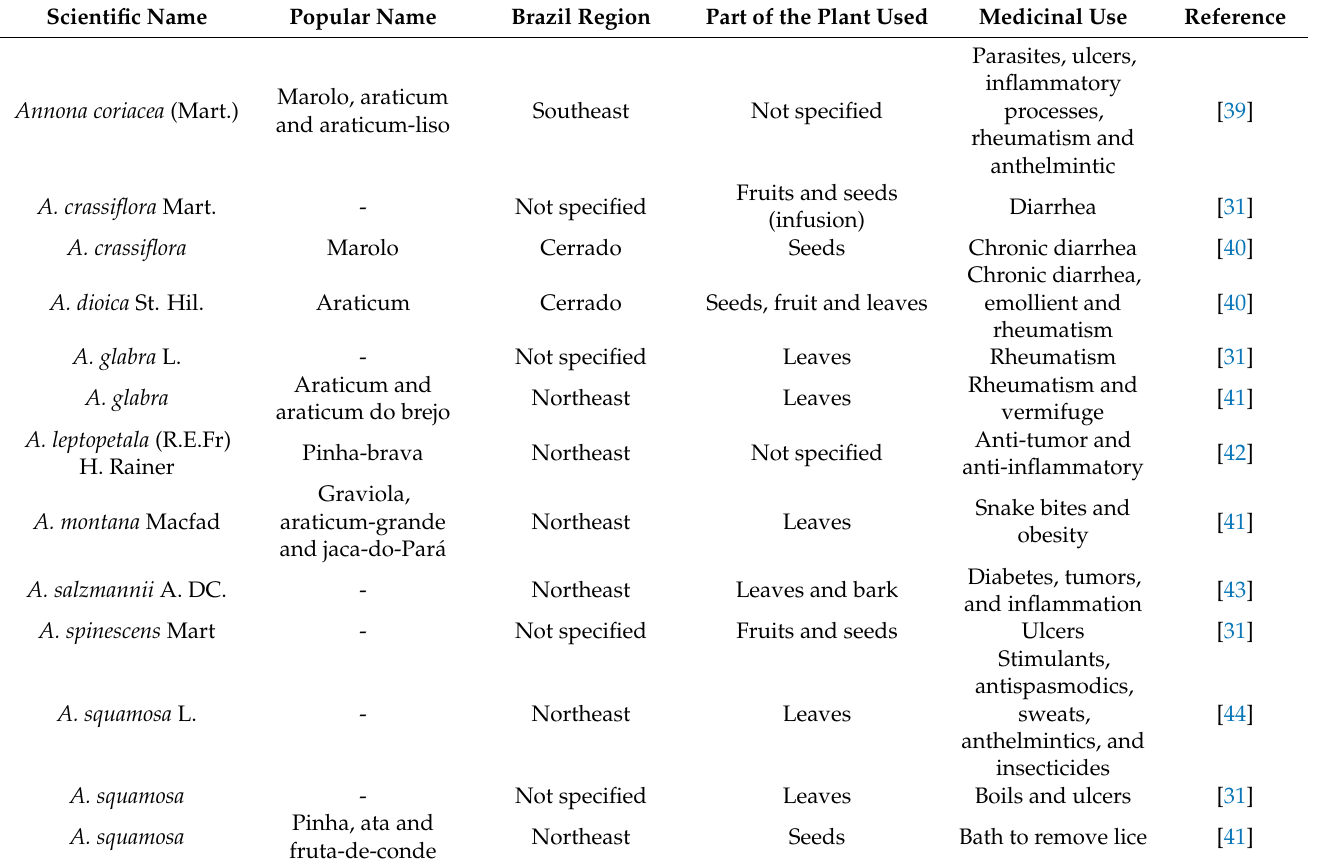
Table 1. Ethnobotanical use of Annonaceae species occurring in